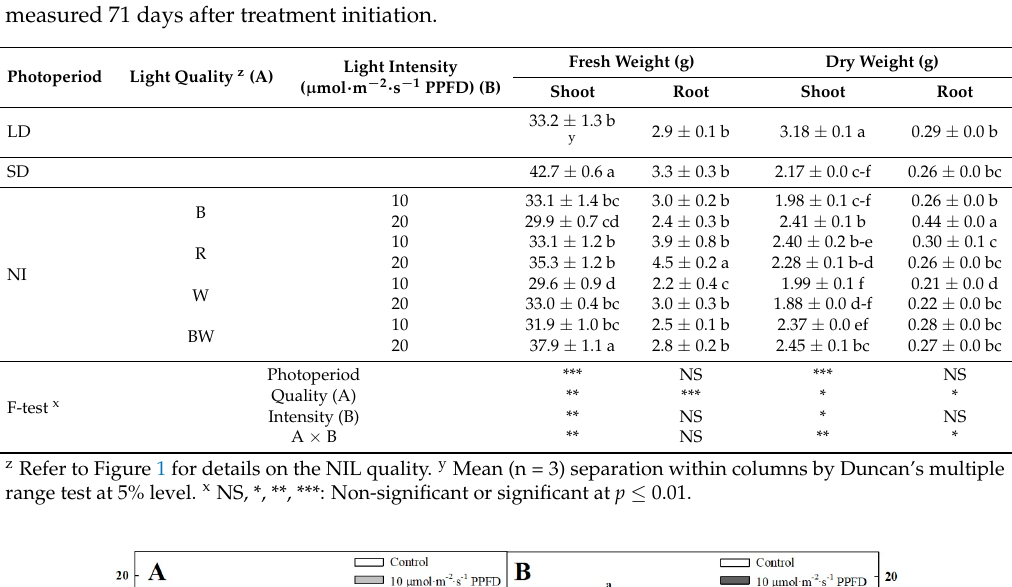
z Refer to Figure 1 for details on the NIL quality. y Mean (n = 3) separation within columns by Duncan’s multiple range test at 5% level. x NS, **: Non-significant or significant at p ≤ 0.01. Table 2. The effect of the night interruption light (NIL) quality at 10 µ mol · m − 2 · s − 1 or 20 µ mol · m − 2 · s − 1 PPFD on the fresh and dry weights of kalanchoe ( Kalanchoe blossfeldiana ) ‘Spain’ shoot and root measured 71 days after treatment initiation.